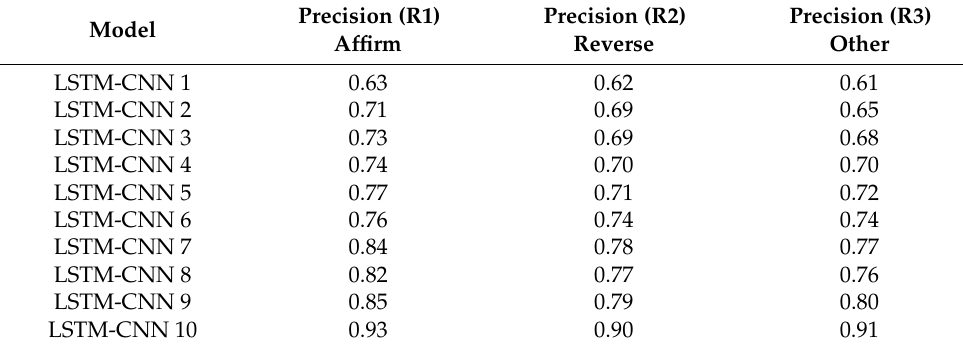
Table 5. LSTM-CNN deep learning models’